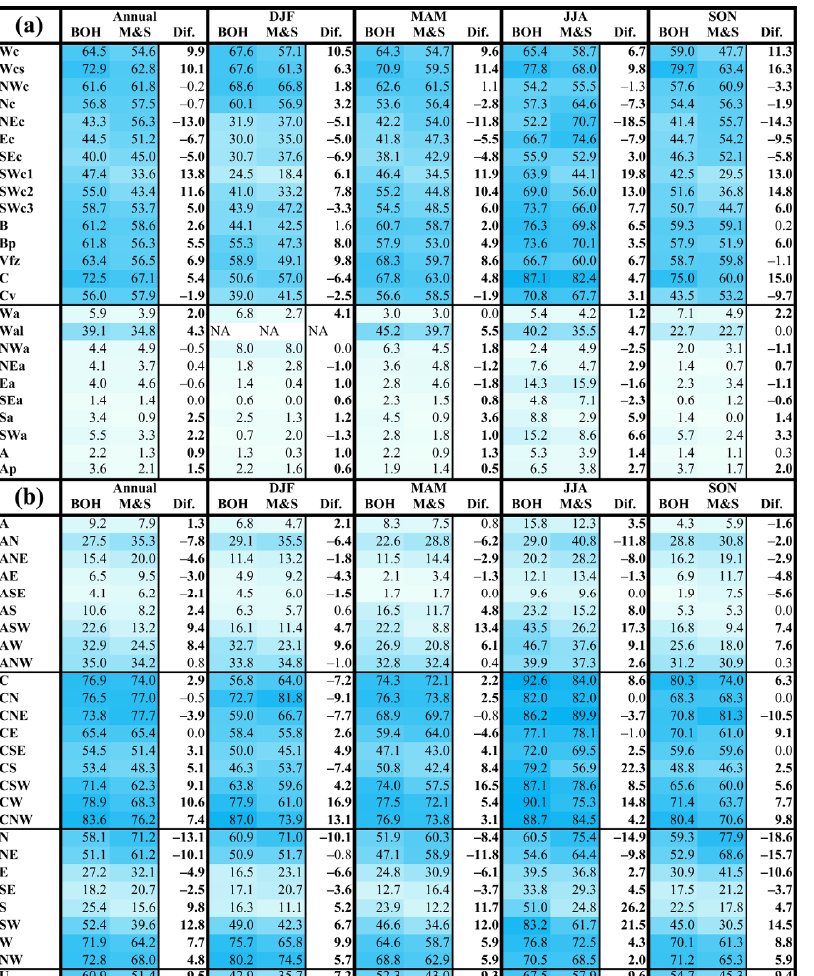
Figure 9. Annual and seasonal (DJF: December–February; MAM: March–May; JJA: June–August; and SON: September–November) probabilities of days with precipitation totals ≥ 1.0 mm for the groups of circulation types under the CHMI ( a ) and objective ( b ) classifications in Bohemia (BOH) and Moravia and Silesia (M&S) during the 1961–2020 period.